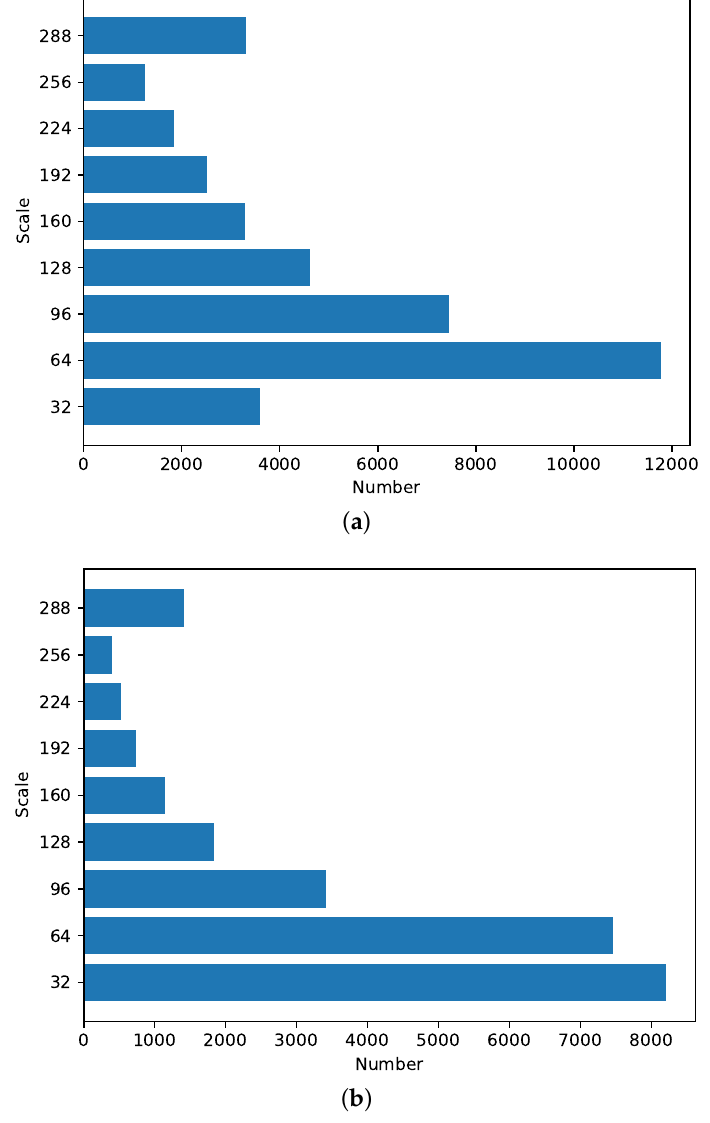
Figure 1. The distribution of the range of variation of the object scale on the KITTI and BDD100K datasets. The scale on the y-axis represents the maximum side length of the object’s bounding box. The x-axis represents the number of objects whose scale does not exceed the corresponding value of the y-axis. ( a ) KITTI. ( b )